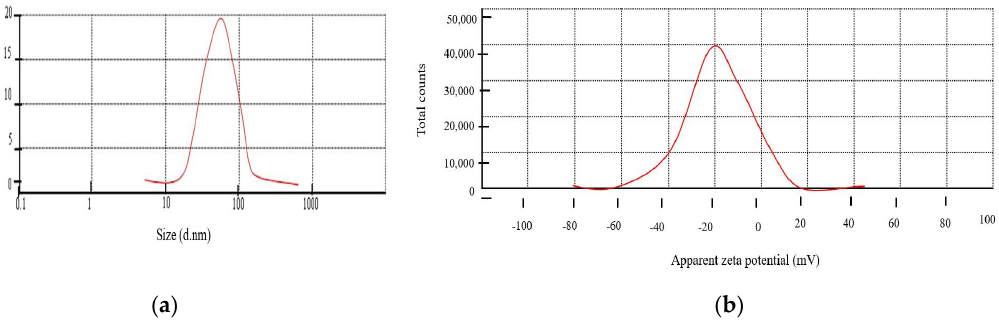
Figure 7. ( a ) Hydrodynamic size distribution. ( b ) Zeta potential (mV) of the synthesized silver na- noparticles.